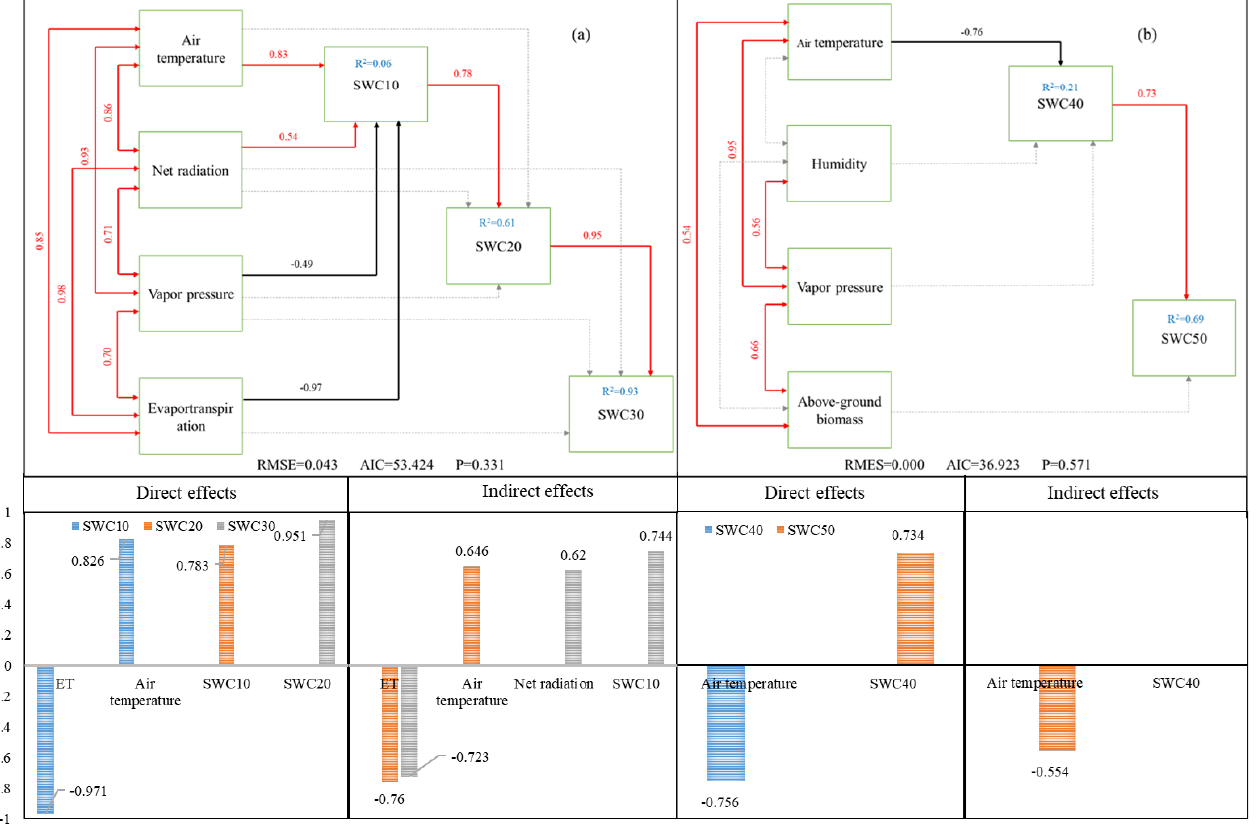
Figure 9. The direct and indirect effects of environmental factors on soil water content from a structure equation models (SEM). ( a ) SEMs for the topsoil (030 cm) and ( b ) subsoil (40–50 cm). Arrowheads indicate the hypothesized direction of causation. Red and black arrows reflect positive and negative relationships, respectively. Grey dotted arrows indicate insignificant relationship. The numbers adjacent to the arrows are the standardized path coefficients. R 2 is the proportion of the variation explained by all paths. Meteorological, biological, and soil moisture were monthly-average values in growth season. SWC10, SWC20, SWC30, SWC40, and SWC50 indicate soil water content at the soil depths of 10, 20, 30, 40, and 50 cm, respectively.